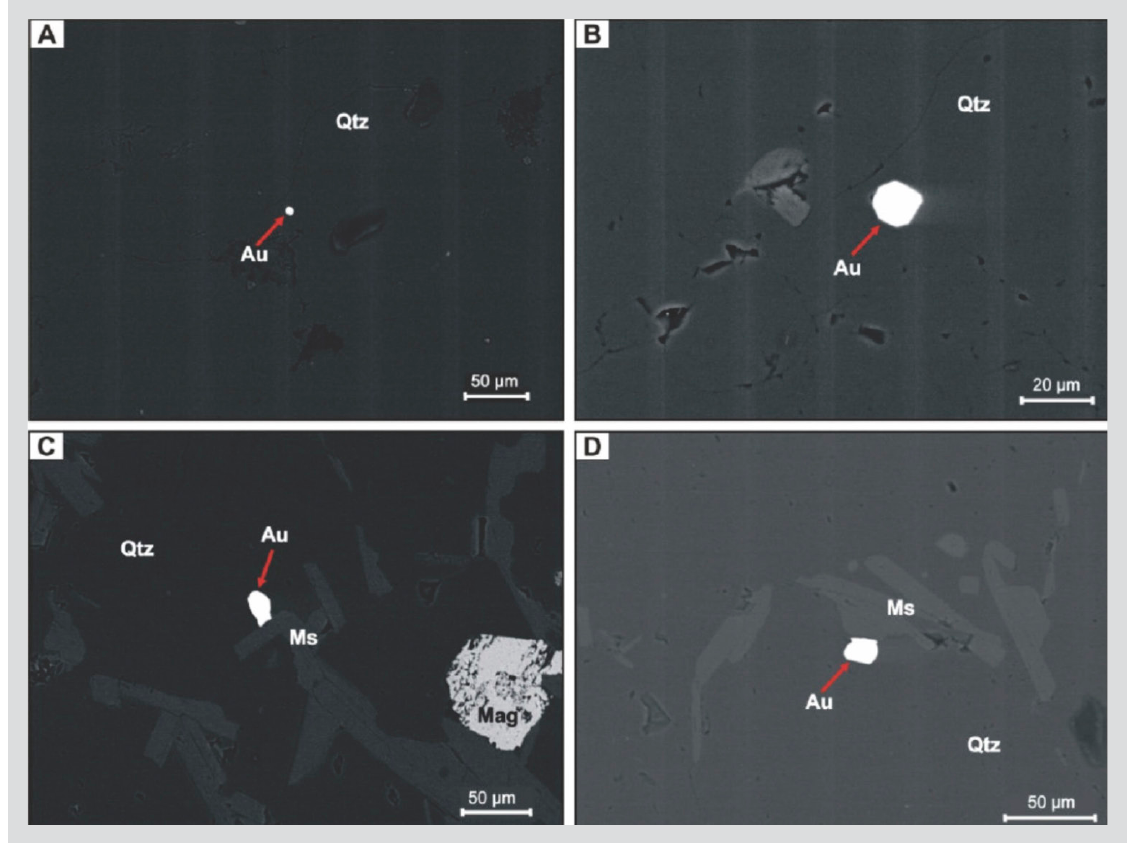
Figure 10 - Backscattered electron images of gold in the matrix of metaconglomerate (thin sections). (A) and (B) Gold in the inner portions of detrital quartz grains. (C) and (D) Intergranular particles in contact with muscovite. Qtz: quartz, Ms: muscovite (white